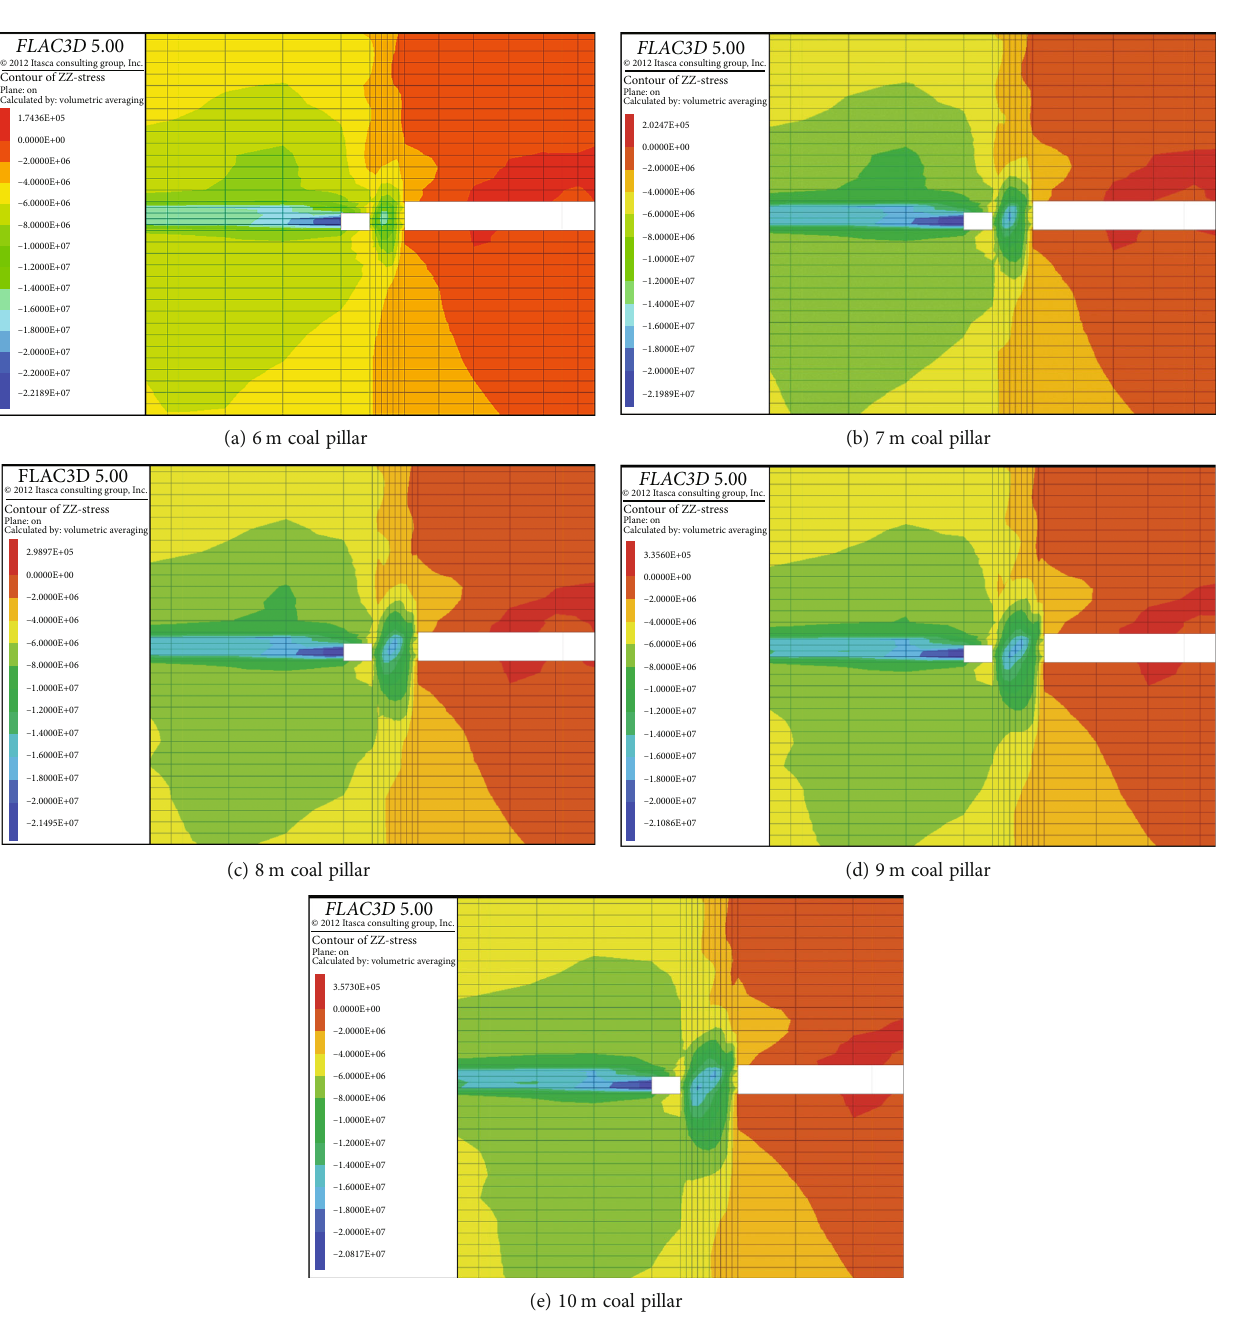
Figure 3: Vertical stress distribution in coal pillars with di ff erent widths and surrounding rock of roadway along goaf when the workface was advanced